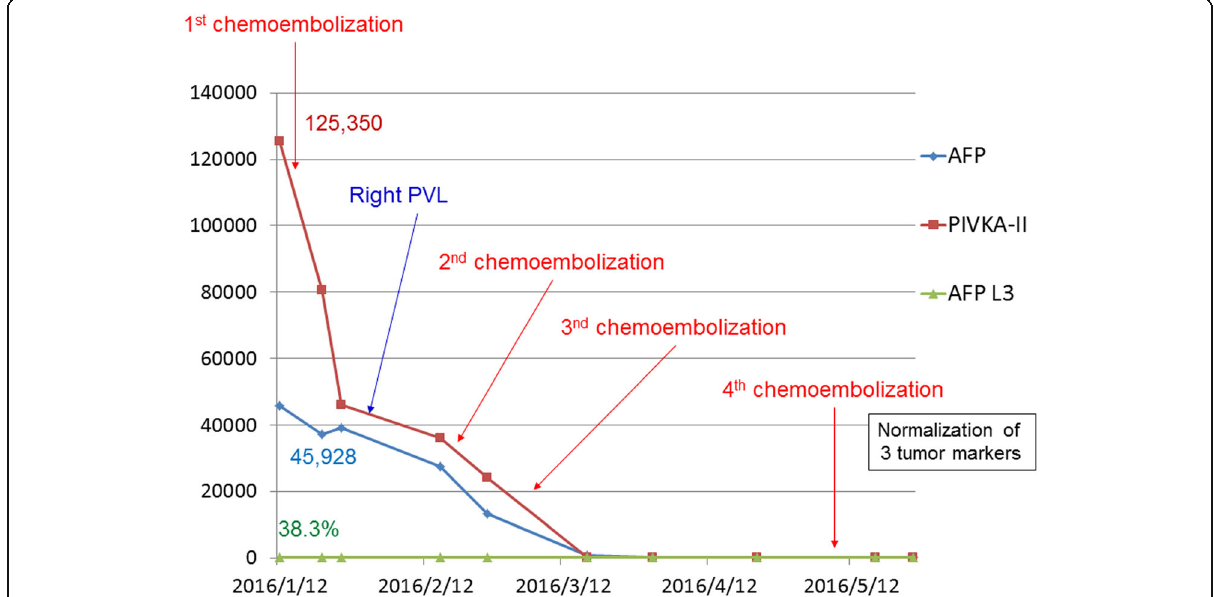
Fig. 3 Treatment course and changes in tumor markers. Tumor markers were abnormally high before the first chemoembolization, but they remained within the normal range for 18 months after the fourth chemoembolization